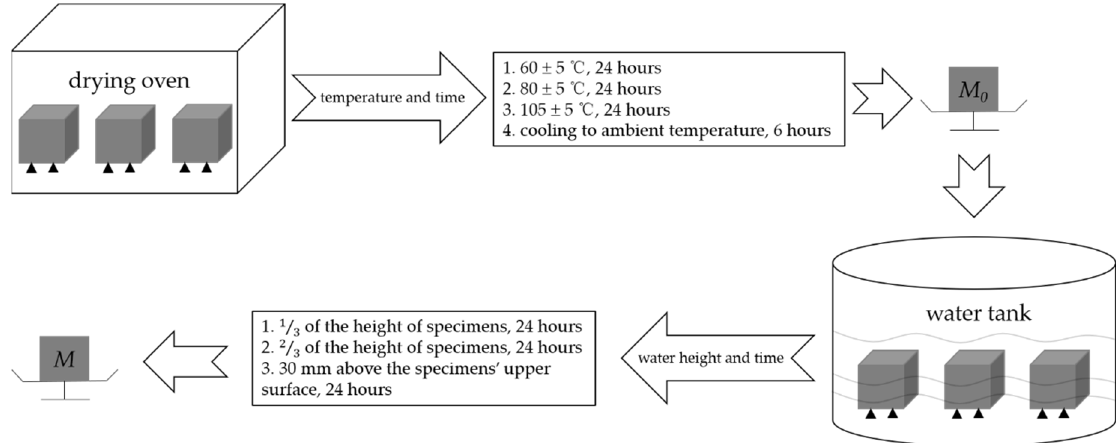
Figure 7. Process of water absorption test.